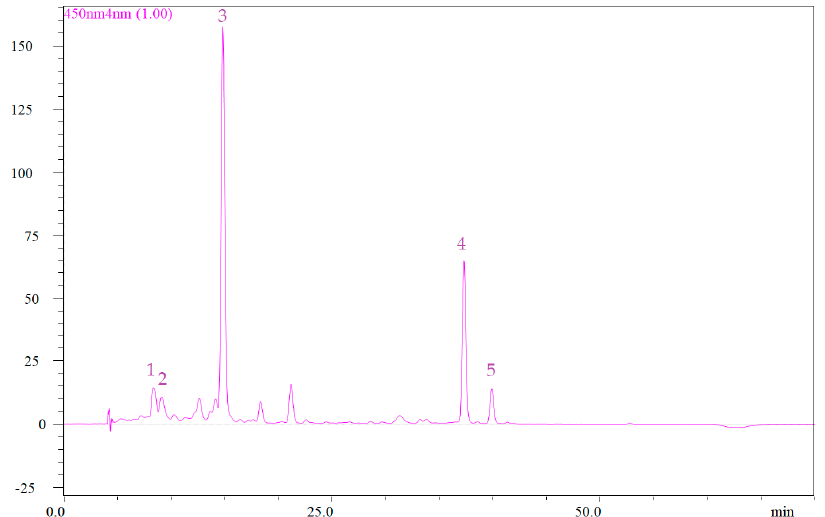
Figure 3. HPLC chromatogram of carotenoids identified from C. persicum leaves (LC1). Peak no. 1, neoxanthin; 2, violaxanthin; 3, lutein; 4, β− carotene; 5, cis −β− carotene. Table 2. Carotenoids composition (µg/g fresh (fw) and dry weight (dw) ± SD) in Cyclamen geno- types leaves.